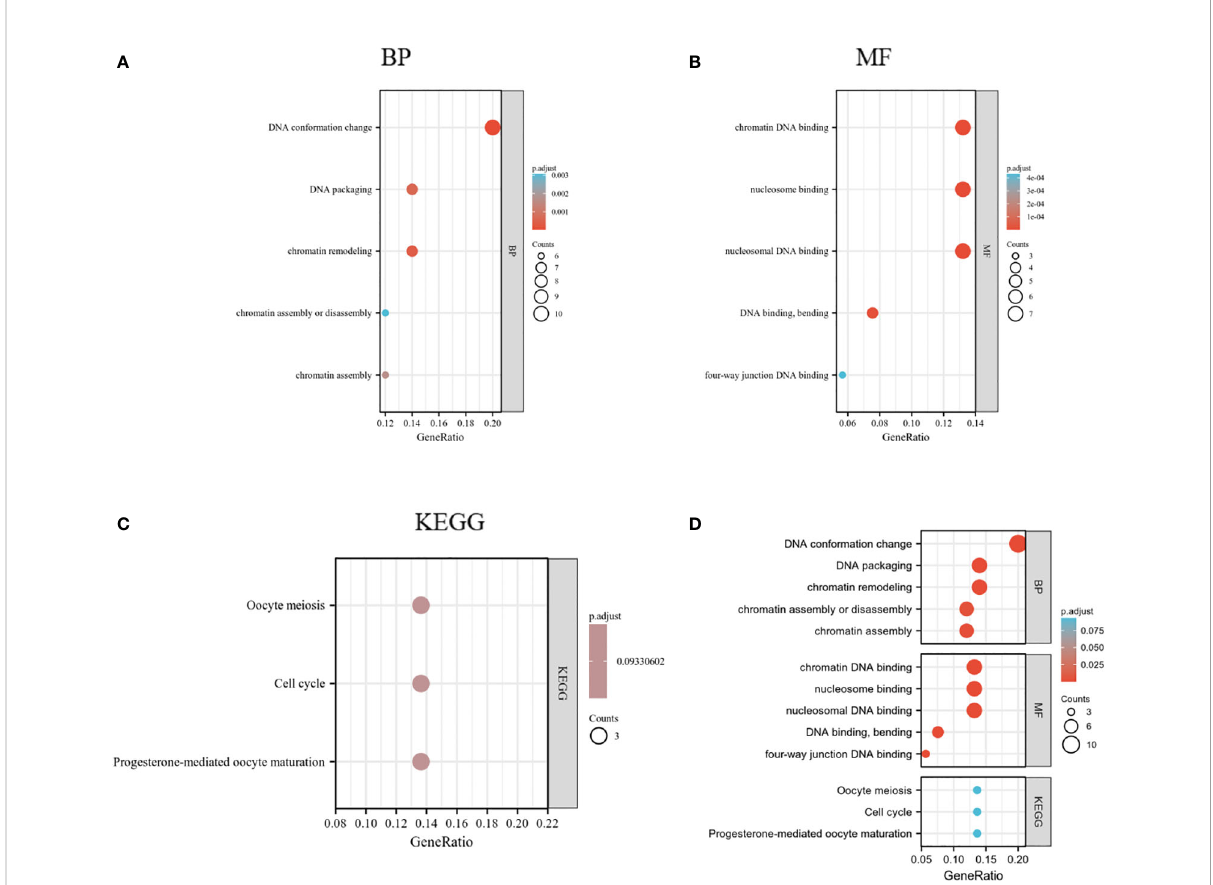
FIGURE 11 GO and KEGG enrichment analysis of HMGs. (A) Biological process (BP); (B) Molecular function (MF); (C) Kyoto Encyclopedia of Genes and Genomes (KEGG); (D) Summary plot of enrichment